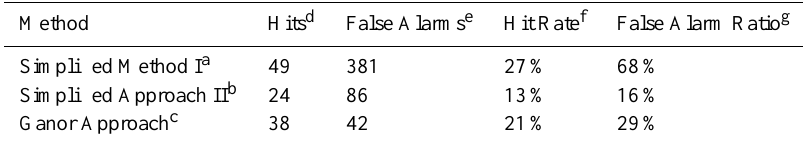
Table 2. Comparisons of three simplified dust identification methods to the full method proposed in this study. Here the dust records identified by the full method are used as reference data to calculate hits and false